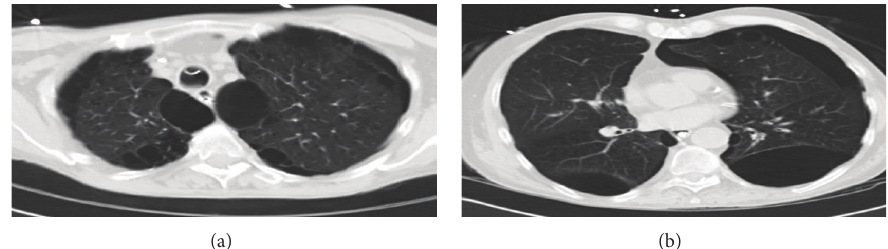
Figure 3: Chest CT axial view showing bilateral upper lobe (a) and lower lobe (b) bullae compressing surrounding relatively normal lung